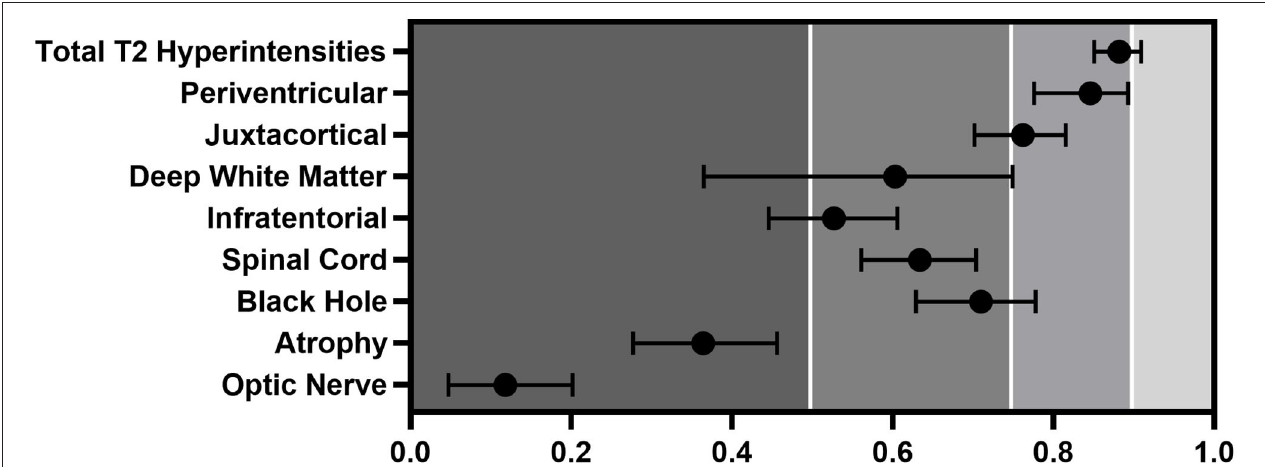
FIGURE 2 | ICC with of the different regions evaluated by the four closest raters. Error bars represent CIs.